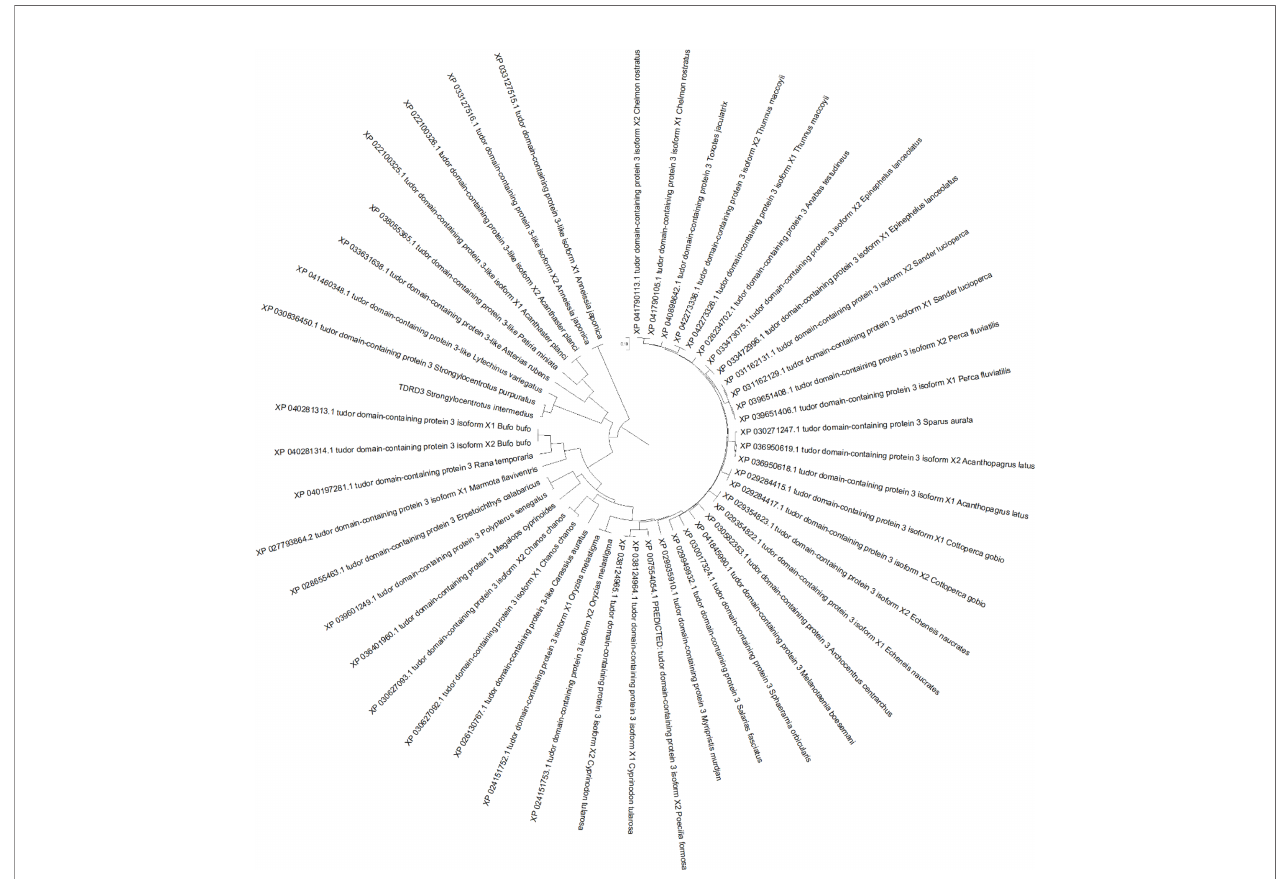
FIGURE 6 | Phylogenetic relationship of tudor domain-containing protein 3 (TDRD3) among Strongylocentrotus intermedius and related